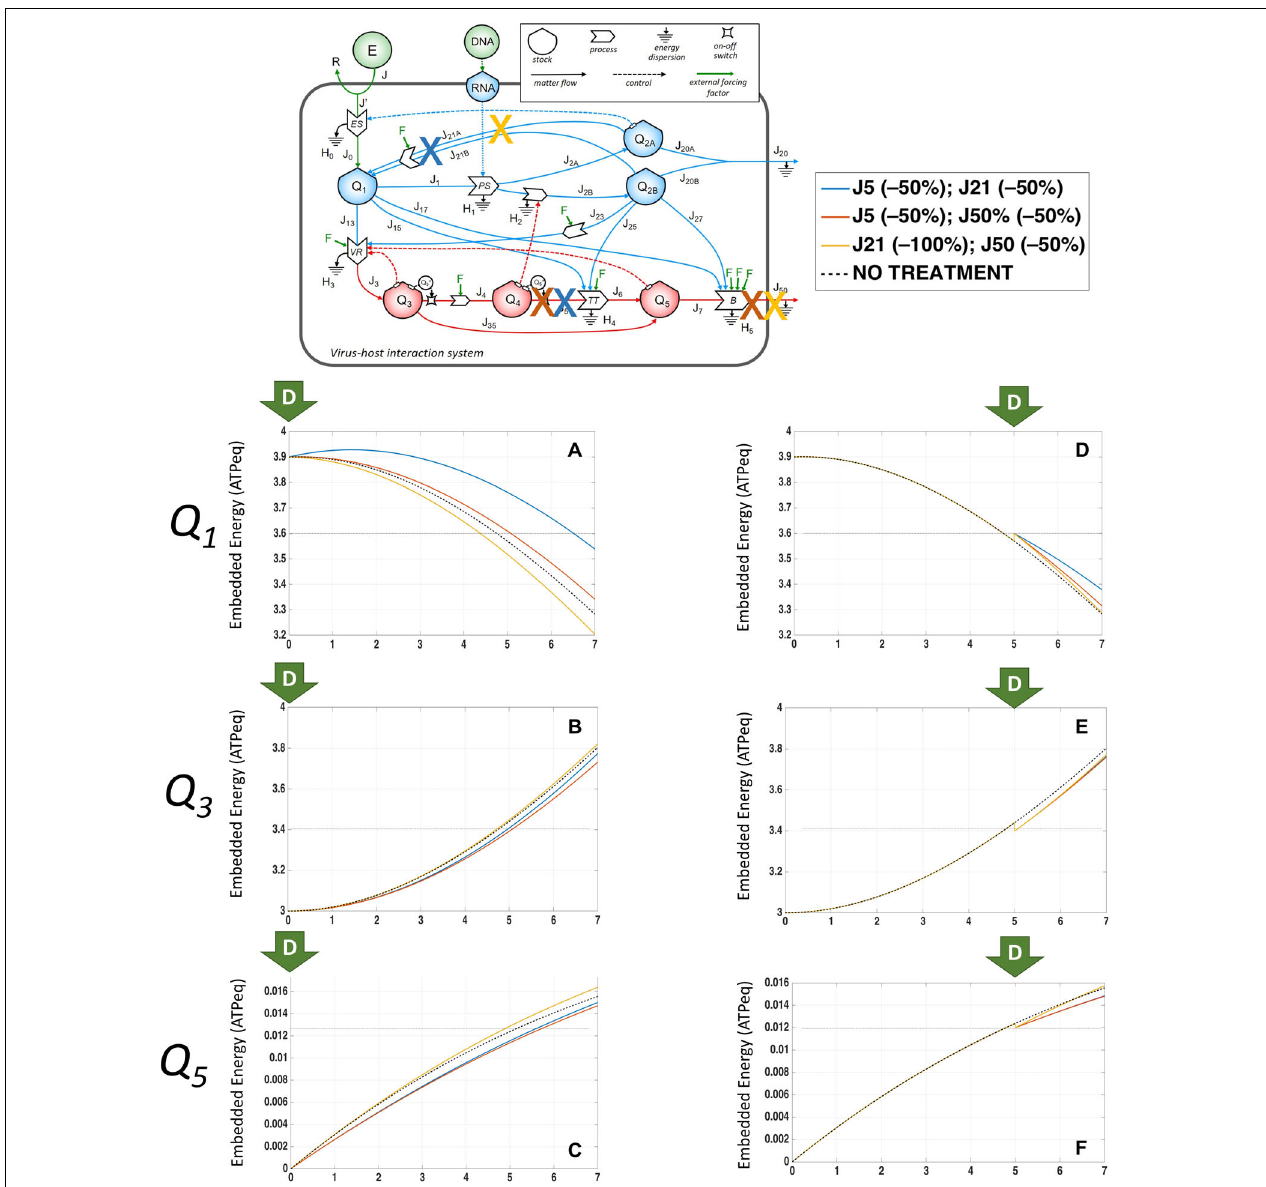
FIGURE 8 | System configurations dynamics in response to multiple external driving forces applied at different timepoints from infection. Changes over time of Q 1 stocks, expressed in ATP-eq, in response to partial (50%) reduction of J 5 and J 21 (blue line), J 5 and J 50 (orange line), J 21 and J 50 (yellow line), or no application of external driving forces applied at Day 0 (A) or at Day 5 (D) of infection. Changes over time of Q 3 stocks, expressed in ATP-eq, in response to partial (50%) reduction of J 5 and J 21 (blue line), J 5 and J 50 (orange line), J 21 and J 50 (yellow line), or no application of external driving forces applied at Day 0 (B) or at Day 5 (E) of infection. Changes over time of Q 5 stocks, expressed in ATP-eq, in response to partial (50%) reduction of J 5 and J 21 (blue line), J 5 and J 50 (orange line), J 21 and J 50 (yellow line), or no application of external driving forces applied at Day 0 (C) or at Day 5 (F) of